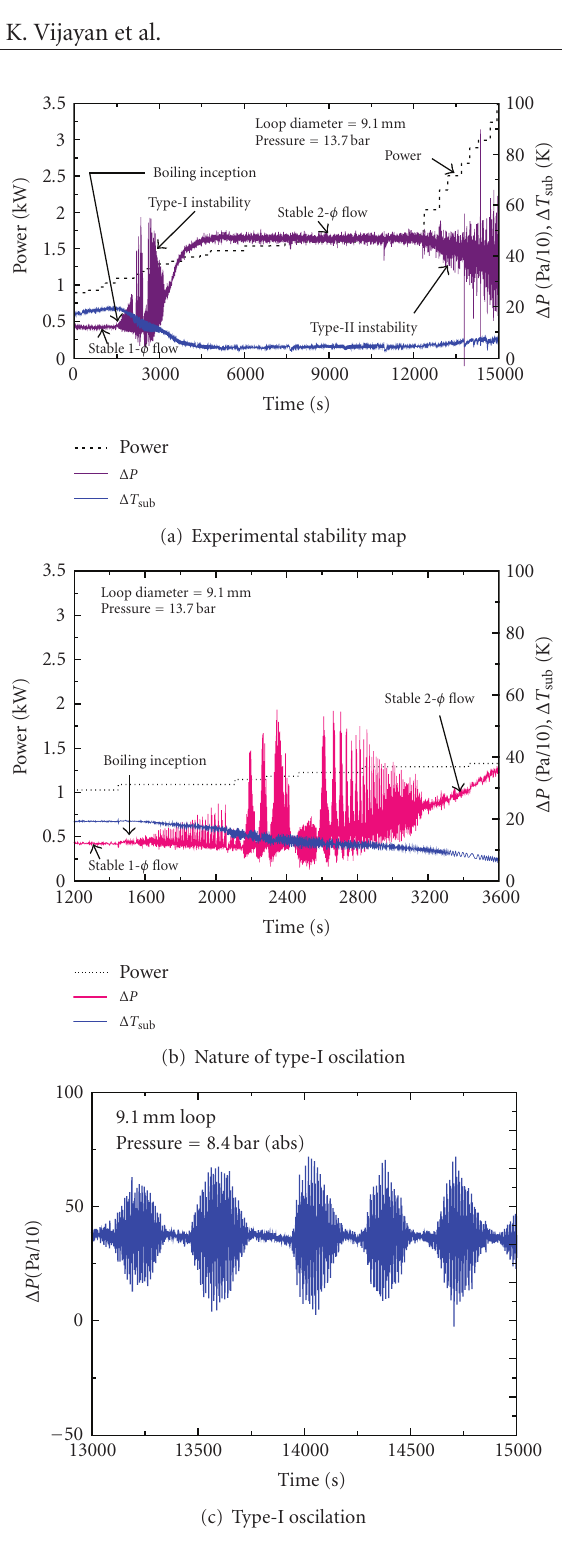
Figure 15: Experimental stability map and some typical type-I